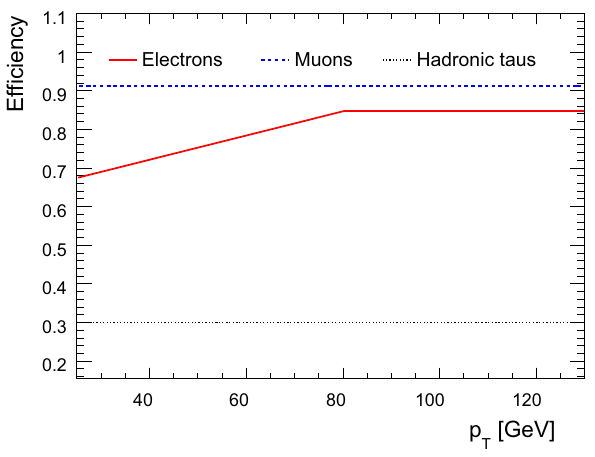
Fig. 1 The overall efficiencies assumed for the reconstruction, identi- fication, and isolation criteria for prompt e ,μ , and τ had candidates as a function of p